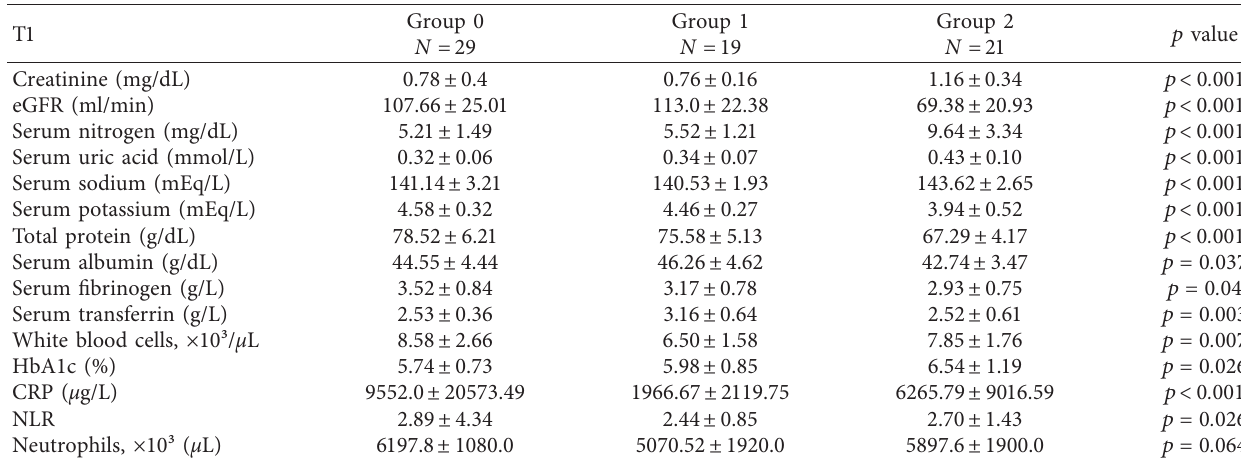
Table 2: Patients’ characteristics at T1 (after 3